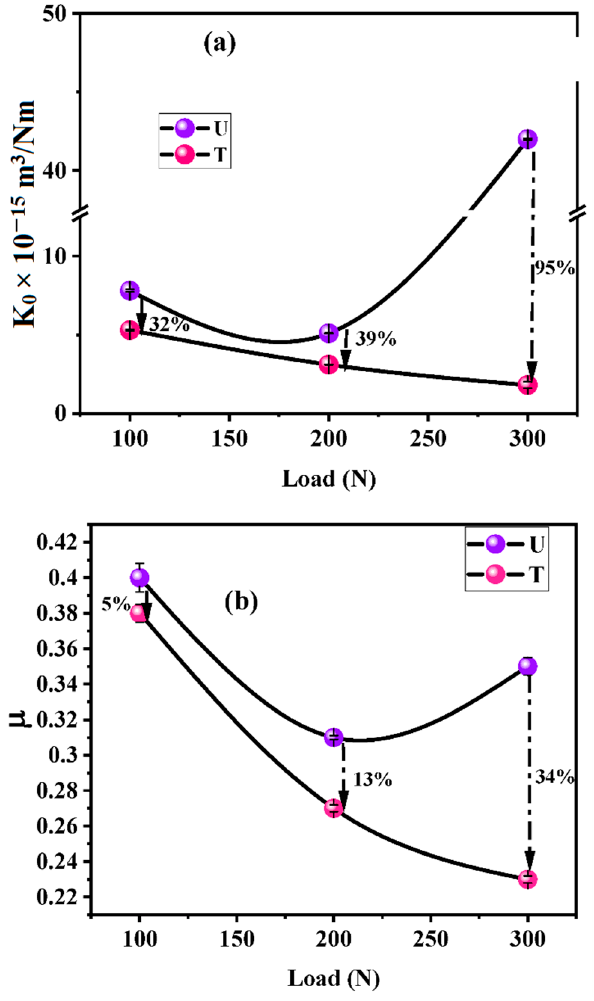
Figure 11. ( a ) Specific wear rate (K 0 ) and ( b ) µ for composites as a function of load (Load—100, 200, and 300 N, speed—1 m/s, sliding distance—7200 m, and time—2 h.). and 300 N, speed—1 m/s, sliding distance—7200 m, and time—2